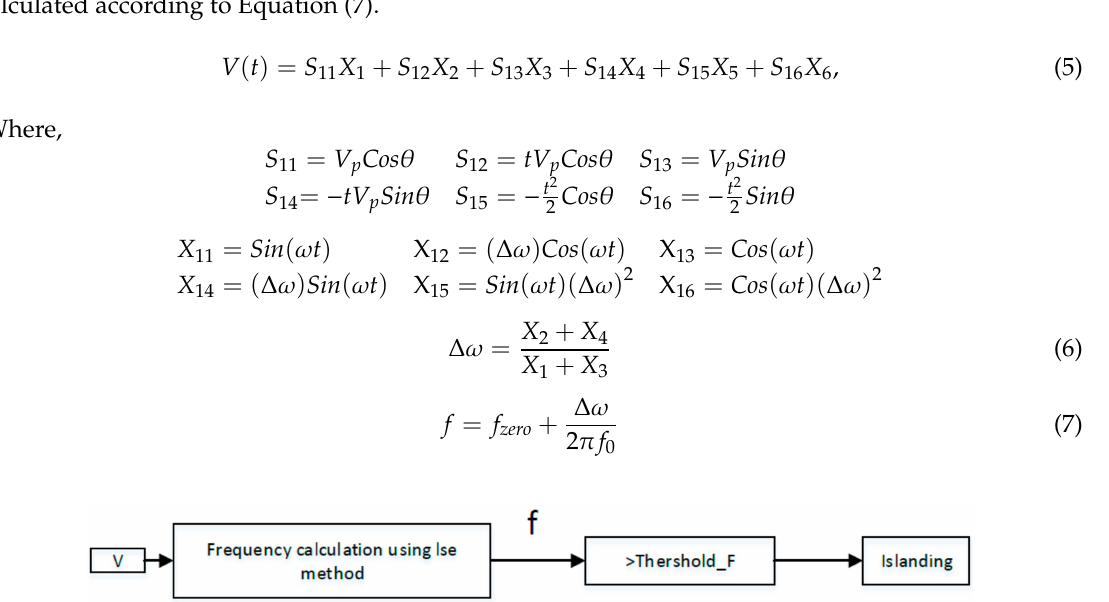
Figure 1. Islanding detection using under frequency (UF) and over frequency (OF)